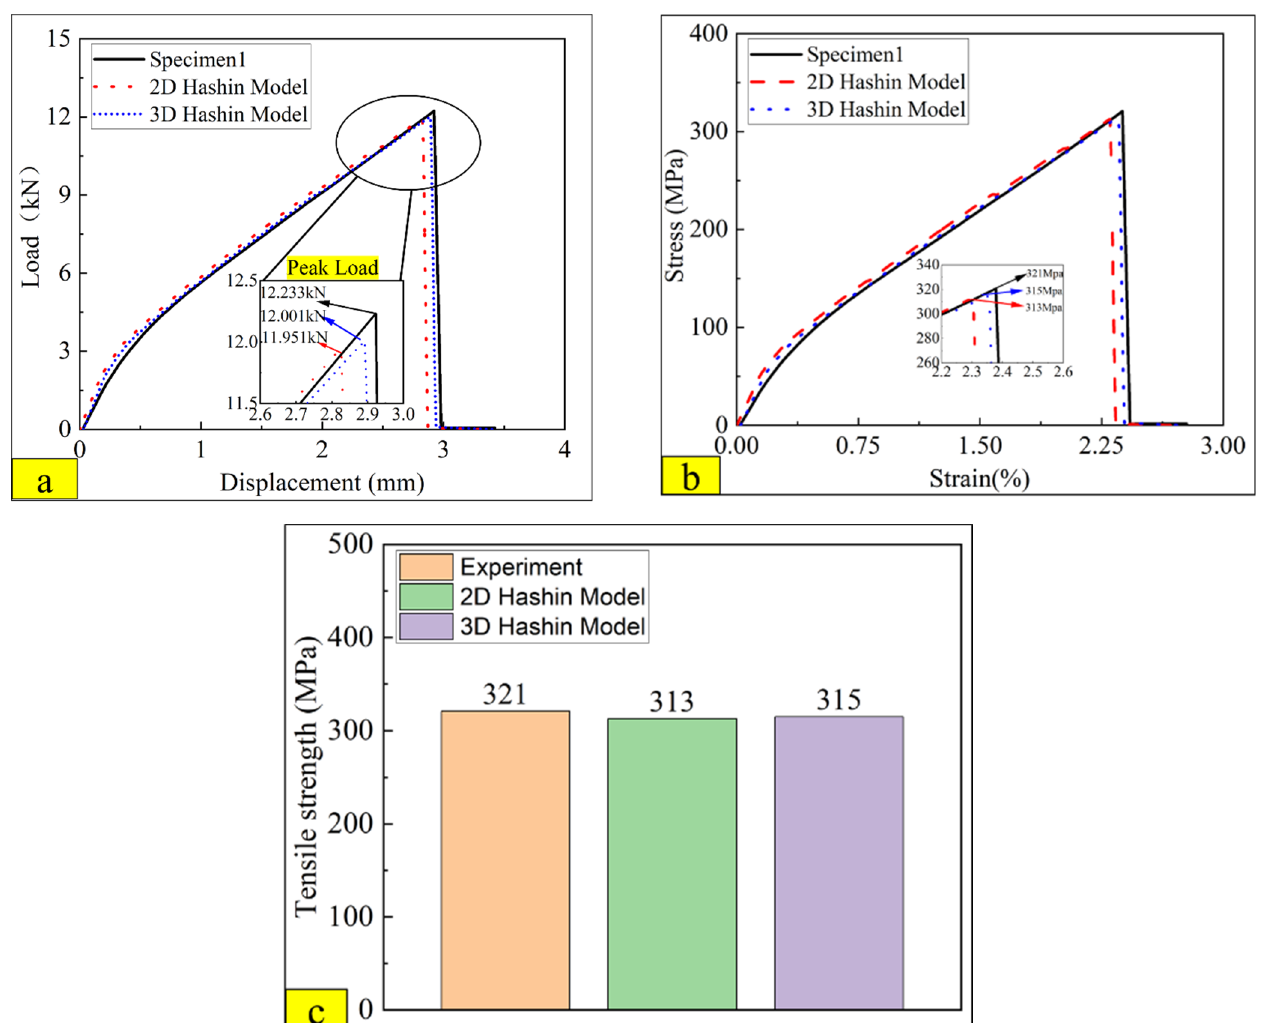
Figure 12. Comparison results of the tensile test on 2D and 3D Hashin model ( a ) load versus dis- placement curves comparison ( b ) true strain-stress curves comparison ( c ) tensile strength compari- son.